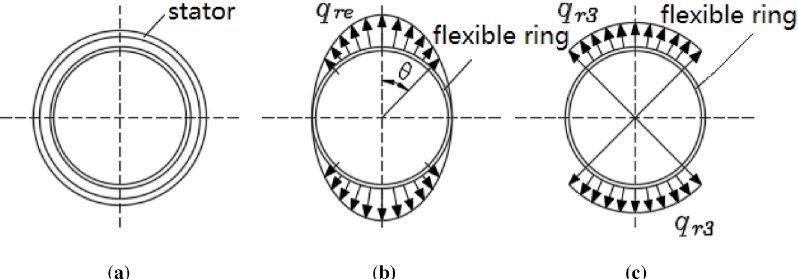
Fig. 2. Electromagnetic and molecular forces on the fl exible ring. (a) Flexible ring and stator (b) electromagnetic force (c) molecular